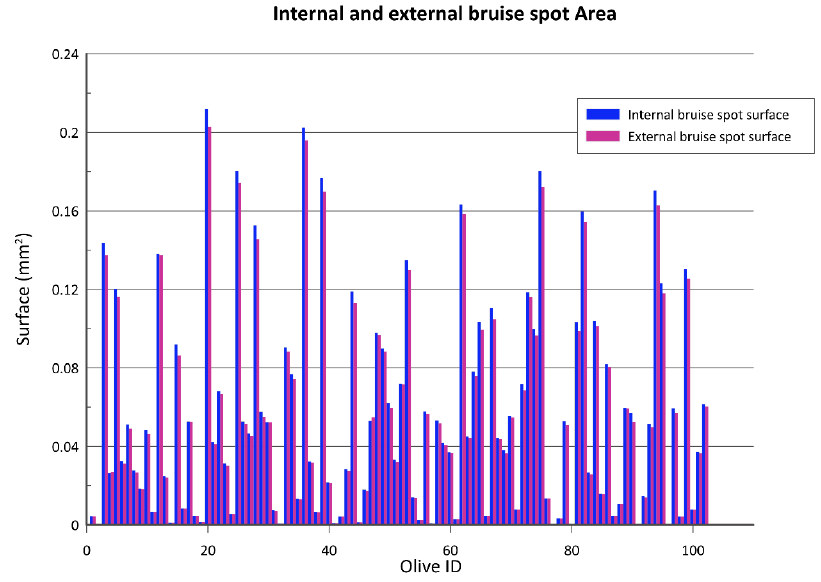
Figure 27. Internal and external bruise area plot.